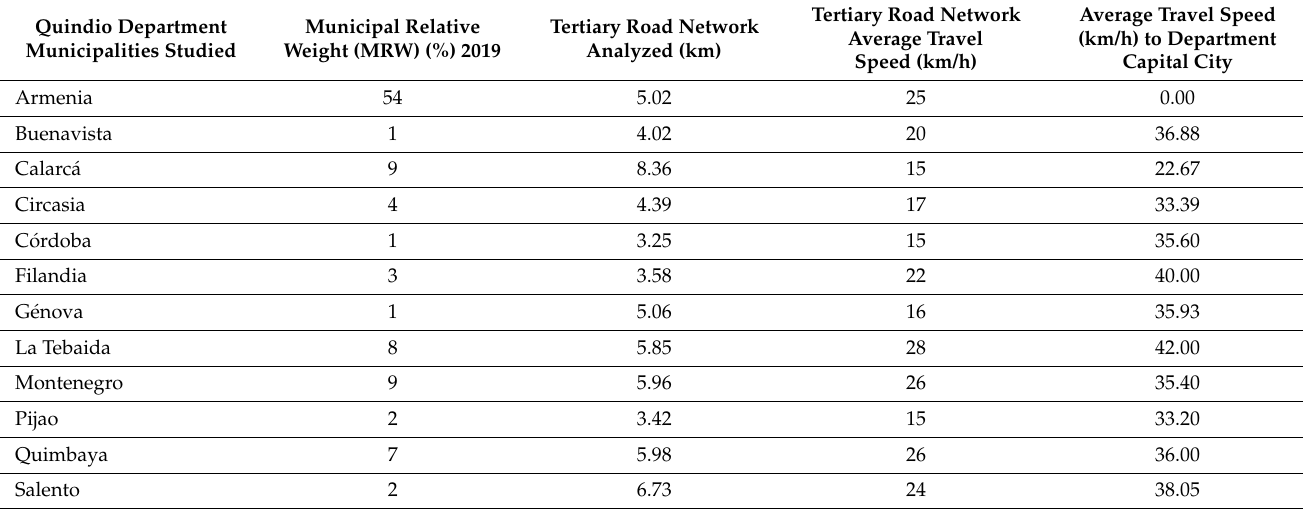
Table A5. Quindio department municipalities studied information: MRW, tertiary road network length, and average travel speed.